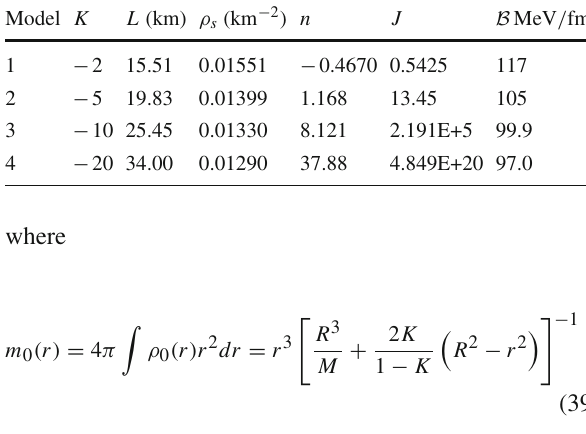
Table 1 Model parameters of initial unstable static configuration Model